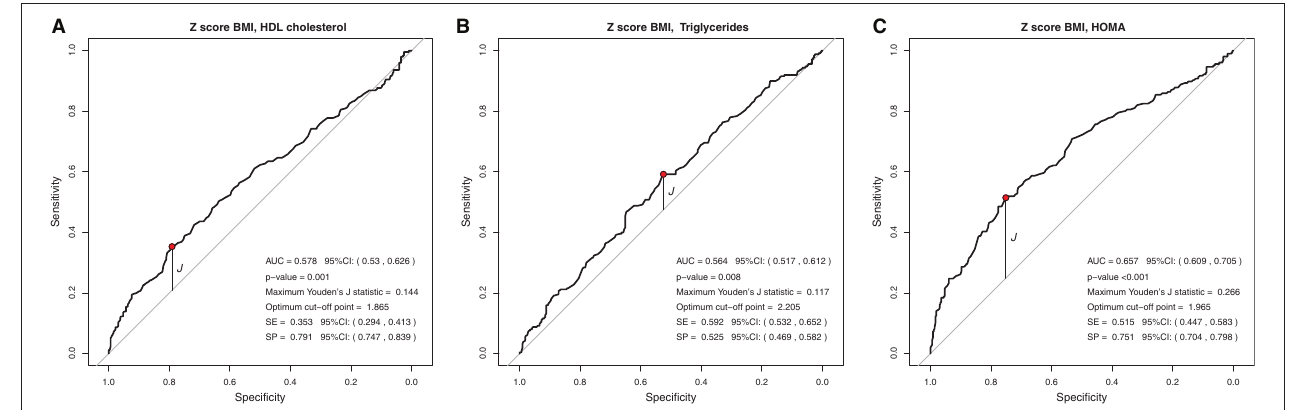
FIGURE 1 | (A–C) Suggested cutoff points for the BMI z-score, with greater ability to rule out changes in HDL-c, TG, and HOMA-IR levels.